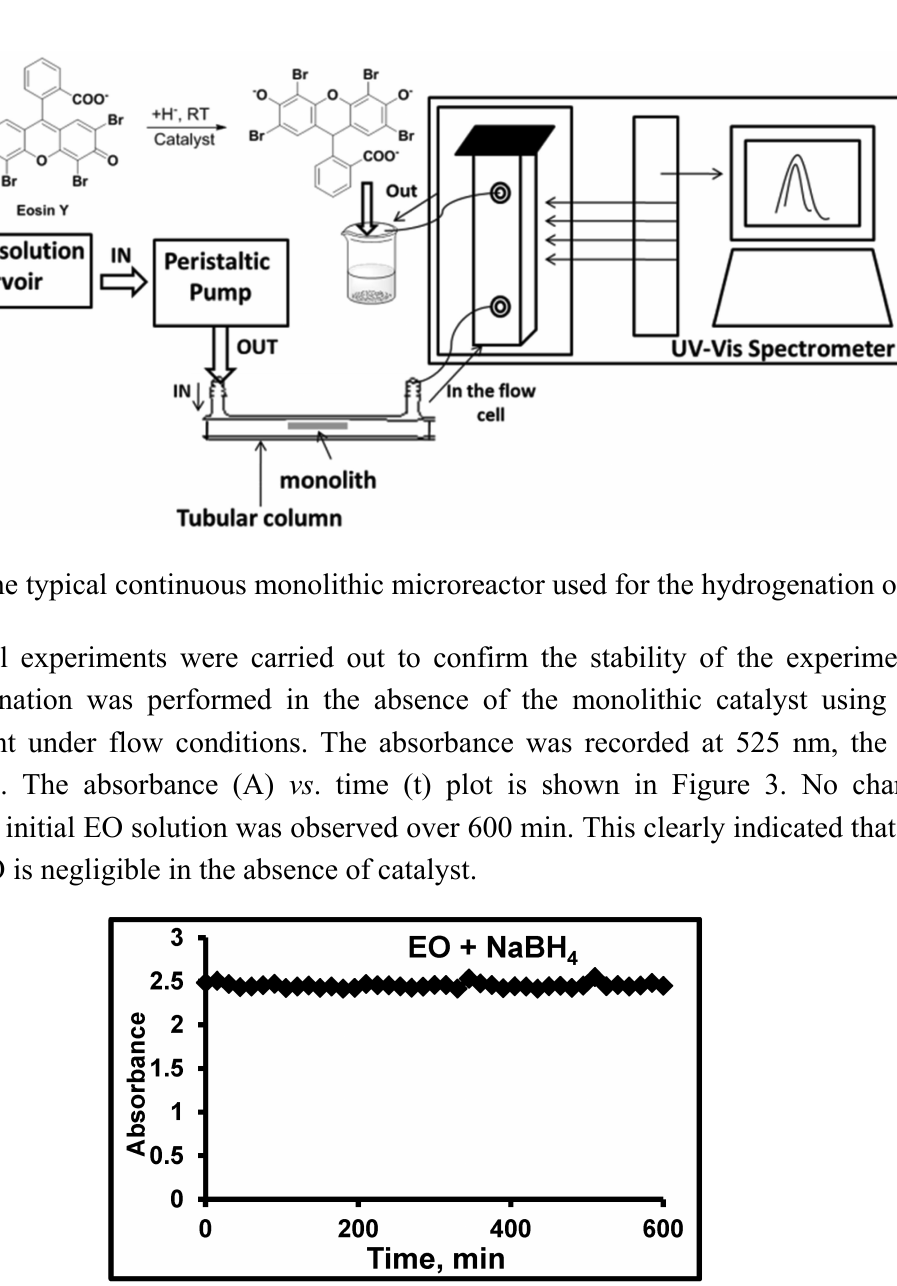
Figure 3. Reaction of EO and NaBH 4 in the absence of catalyst (absorbance (A) vs . time (t)